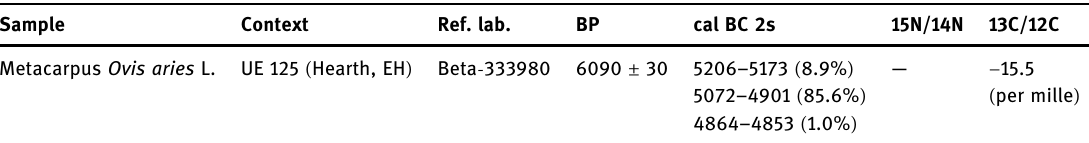
Table 1: Dating available for the Epicardial Early Neolithic at the Cova del Randero. Calibrated to 2 sigmas by INTCAL 2020 curve ( Reimer et al., 2020 ) using Oxcal 4.4.2 software Sample Context Ref.